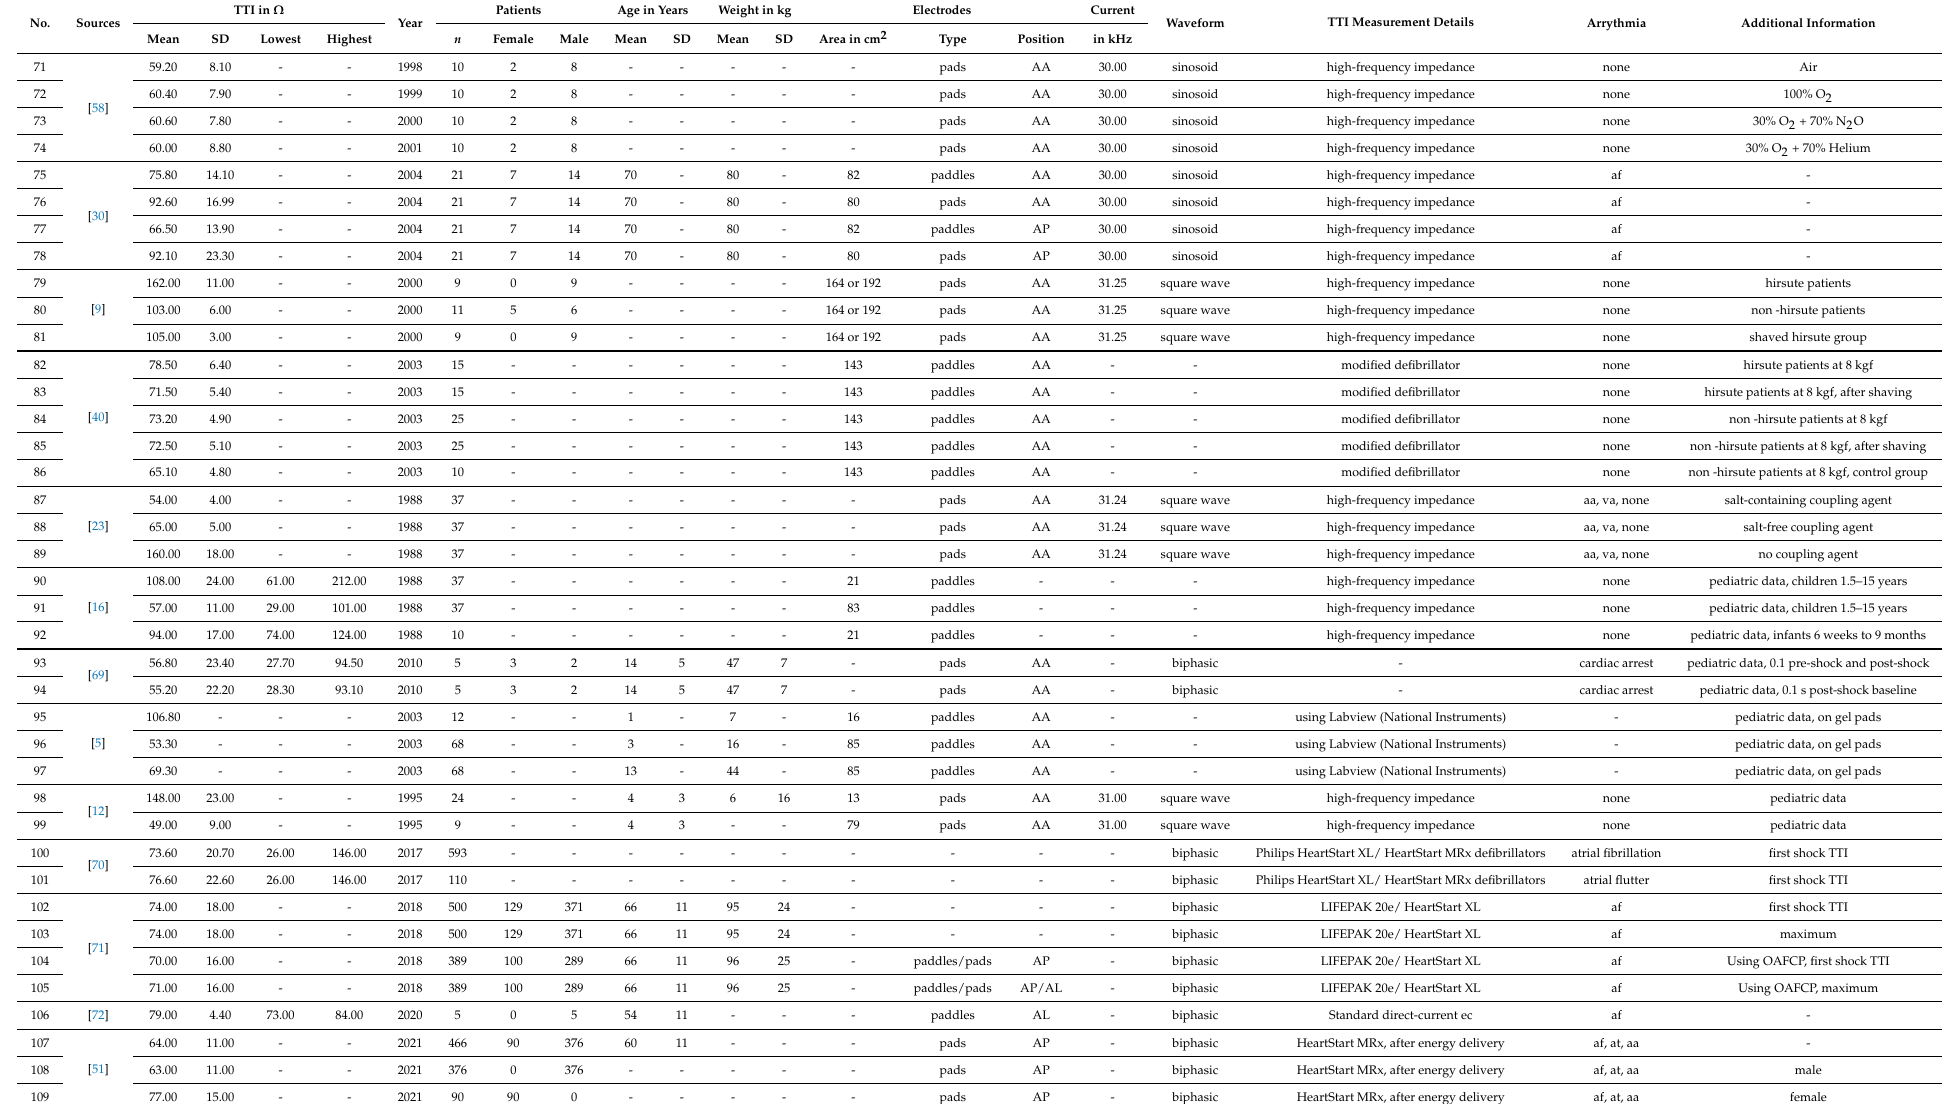
biphasic HeartStartMRx,afterenergydelivery af,at,aa